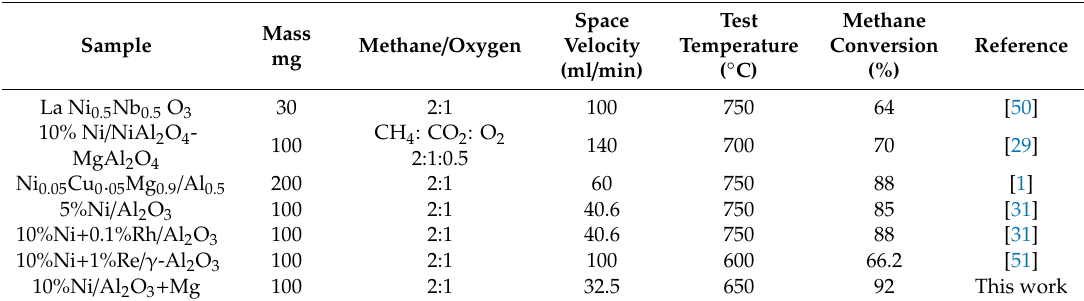
Table 2. Assessment of CH 4 partial